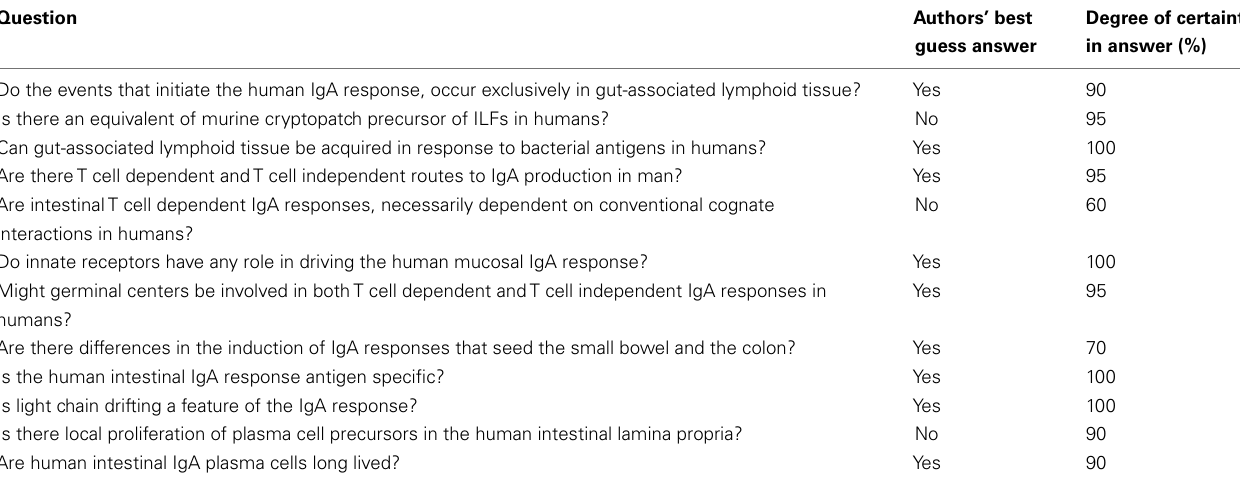
Table 1 | Outstanding questions in human IgA